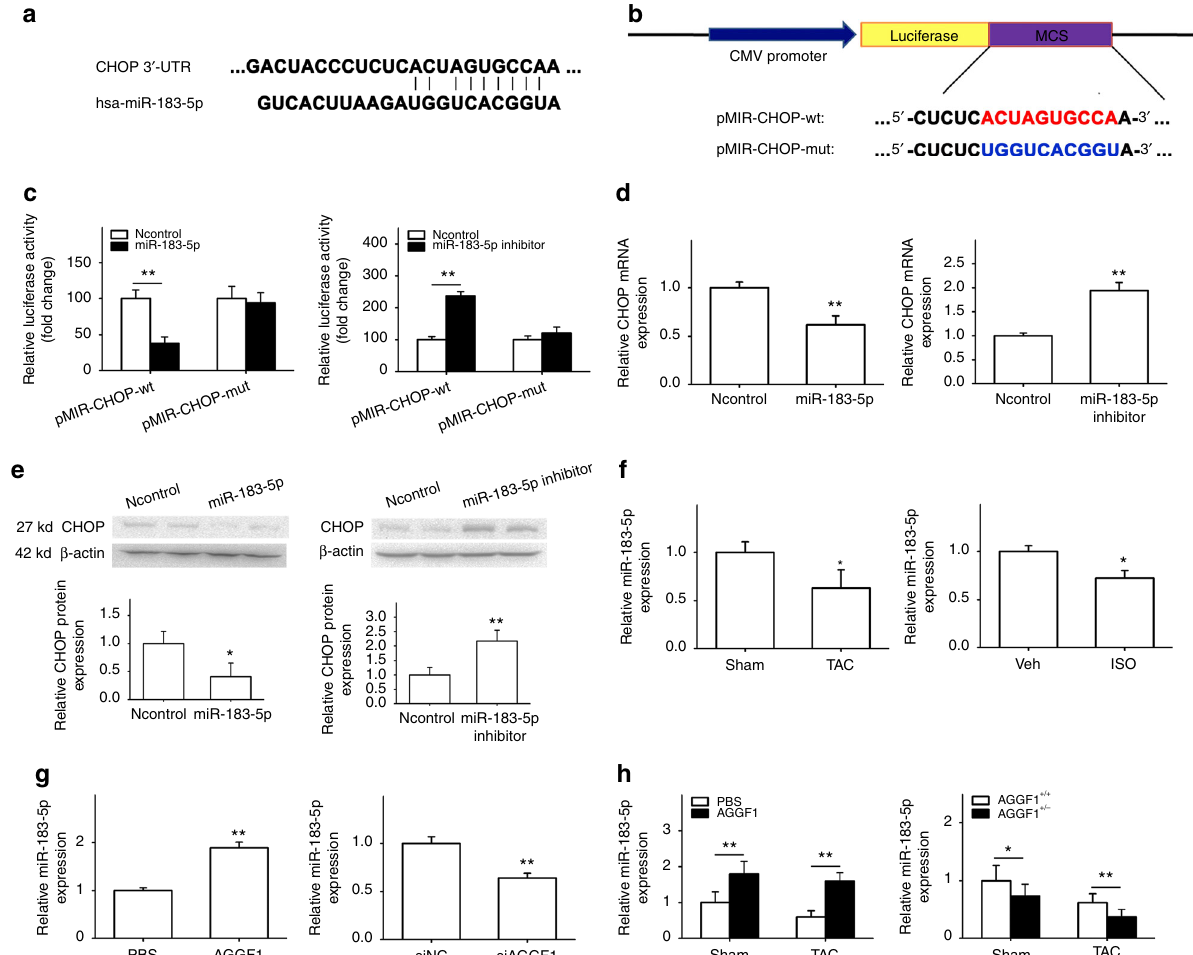
Fig. 5 AGGF1 downregulates expression of CHOP via miR-183-5p . a Bioinformatic analysis of the CHOP mRNA sequence identi fi ed a binding site for miR-183-5p at the 3 ′ -UTR. b Schematic diagram showing the wild type (wt) pMIR-CHOP-wt or mutant pMIR-CHOP-mut reporter with the miR-183-5p- binding site mutated. c Luciferase activity of pMIR-CHOP-wt or mutant pMIR-CHOP-mut reporters in the presence of miR-183-5p mimics, a negative control miRNA mimics (Ncontrol), or a miR-183-5p speci fi c inhibitor ( n = 3/group, ** P < 0.01). d Quantitative real-time RT-PCR analysis for the level of the CHOP mRNA in H9C2 cells with transfection of miR-183-5p mimics or a miR-183-5p-speci fi c inhibitor compared with Ncontrol ( n = 3/group, ** P < 0.01). e Western blot analysis for CHOP abundance in H9C2 cells with transfection of miR-183-5p mimics or a miR-183-5p - speci fi c inhibitor compared with Ncontrol. f Real-time RT-PCR analysis showing decreased miR-183-5p expression in TAC mice ( n = 5/group, * P < 0.05) or in an ISO-induced H9C2 cell model for cardiac hypertrophy ( n = 3/group, * P < 0.05). g Real-time RT-PCR analysis for miR-183-5p expression in H9C2 cells 48 h after AGGF1 treatment ( left , n = 3/group, ** P < 0.01). Real-time RT-PCR analysis for miR-183-5p expression in H9C2 cells transfected with AGGF1- speci fi c siRNA (siAGGF1) or siNC ( right , n = 3/group, ** P < 0.01). h Real-time RT-PCR analysis for miR-183-5p expression in the hearts of TAC or Sham mice with or without AGGF1 treatment ( left , n = 6/group, ** P < 0.01). Real-time RT-PCR analysis for miR-183-5p expression in the hearts of WT ( Aggf1 + / + ) or Aggf1 + / − mice after TAC or sham surgeries ( right , n = 6/group, * P < 0.05, ** P < 0.01). Data are shown as the mean ± s.d. from at least three independent experiments. Statistical analysis was carried out by a Student ’ s two-tailed t and Aggf1 haploinsuf fi ciency further aggravated hypertrophy and suggest that miR-183-5p inhibits cardiac hypertrophy and heart failure by reducing LVEF and LVFS more; Ago-miR-183-5p improves myocardial function. rescued the reduction of LVEF and LVFS induced by TAC in WT mice; Ago-miR-183-5p rescued the reduction of LVEF and LVFS induced by TAC and Aggf1 haploinsuf fi ciency (Fig. 7b – g). The fi nding that miR-183-5p can rescue the effect of Aggf1 haploinsuf fi ciency suggests that Aggf1 acts upstream of miR-183-5p. The same conclusion can be made with regard to the HW/BW ratio (Fig. 7e), LW/BW ratio (Fig. 7f), and the Antago-miR-183-5p inhibitor in mice after TAC. H&E staining cross-sectional diameter of cardiomyocytes (Fig. 7f). Ago-miR- showed that AGGF1 therapy reduced cardiac hypertrophy and 183-5p decreased the HW/BW ratio (Fig. 7e) and the LW/BW heart failure in 6-week-old TAC mice, but the therapeutic ratio (Fig. 7f) in both Aggf1 + / − mice and WT mice after TAC. effect was lost in the presence of the Antago-miR-183-5p inhi- The cross-sectional diameter of cardiomyocytes was decreased in bitor (Fig. 8a). Similarly, echocardiography showed that AGGF1 the Ago-miR-183-5p treatment groups (Fig. 7g). These data increased LVEF and LVFS in TAC mice, but the effect was